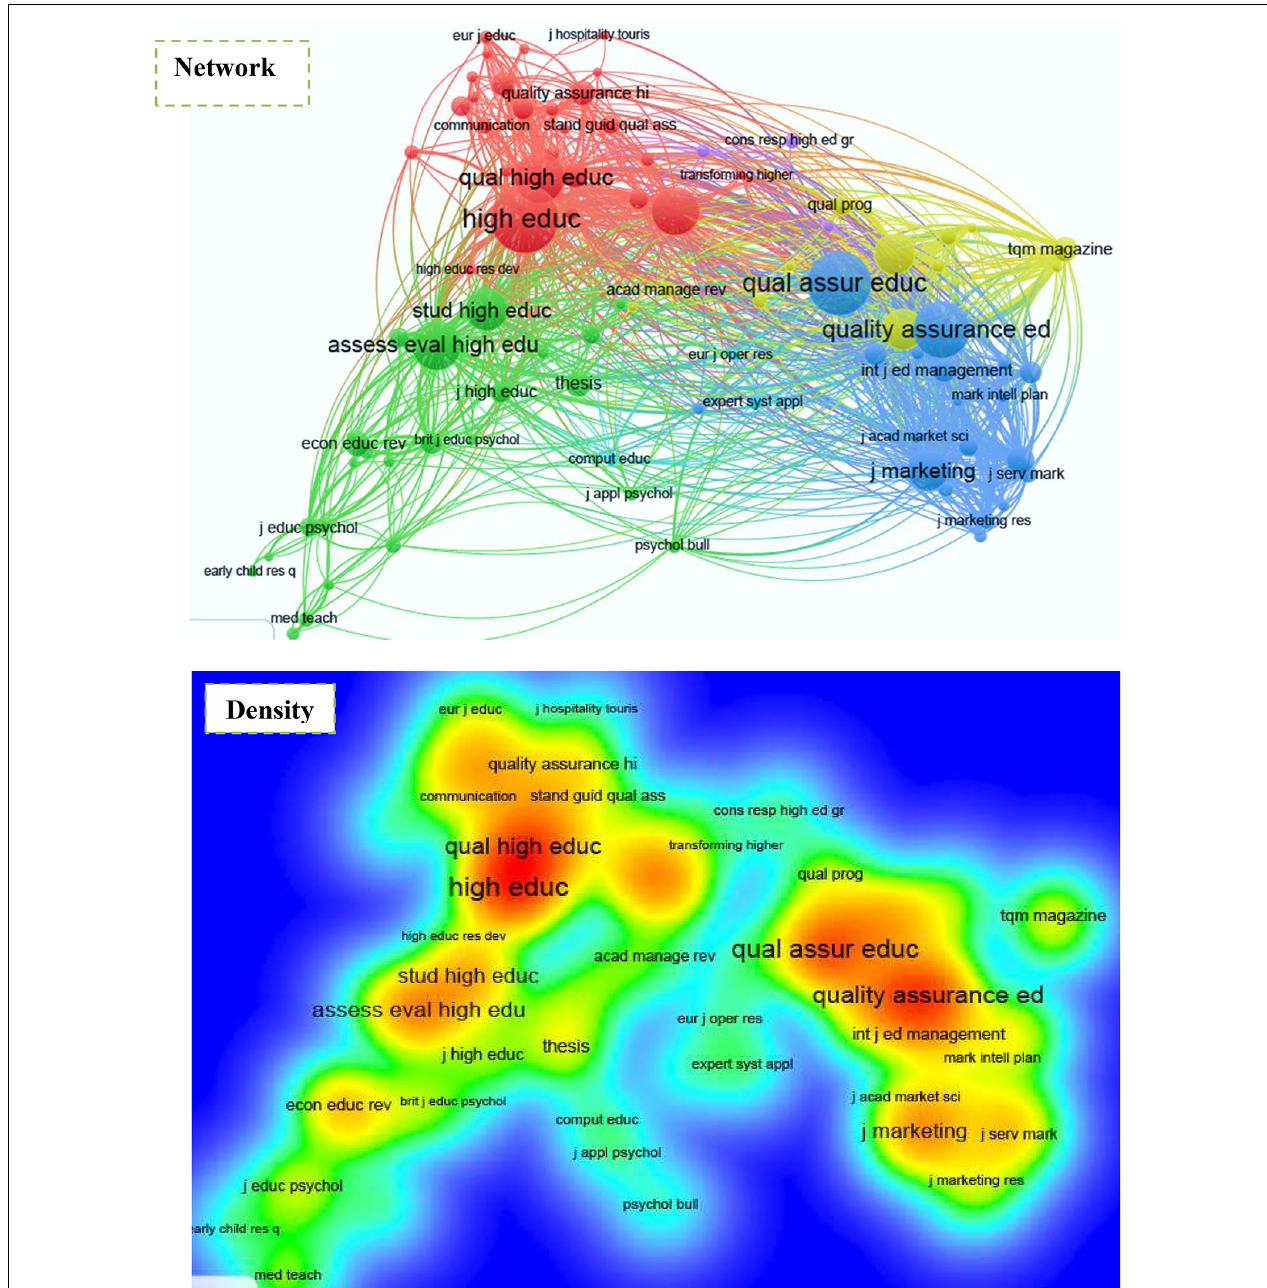
FIGURE 4 | The network and density of the most relevant sources in the field of quality of higher